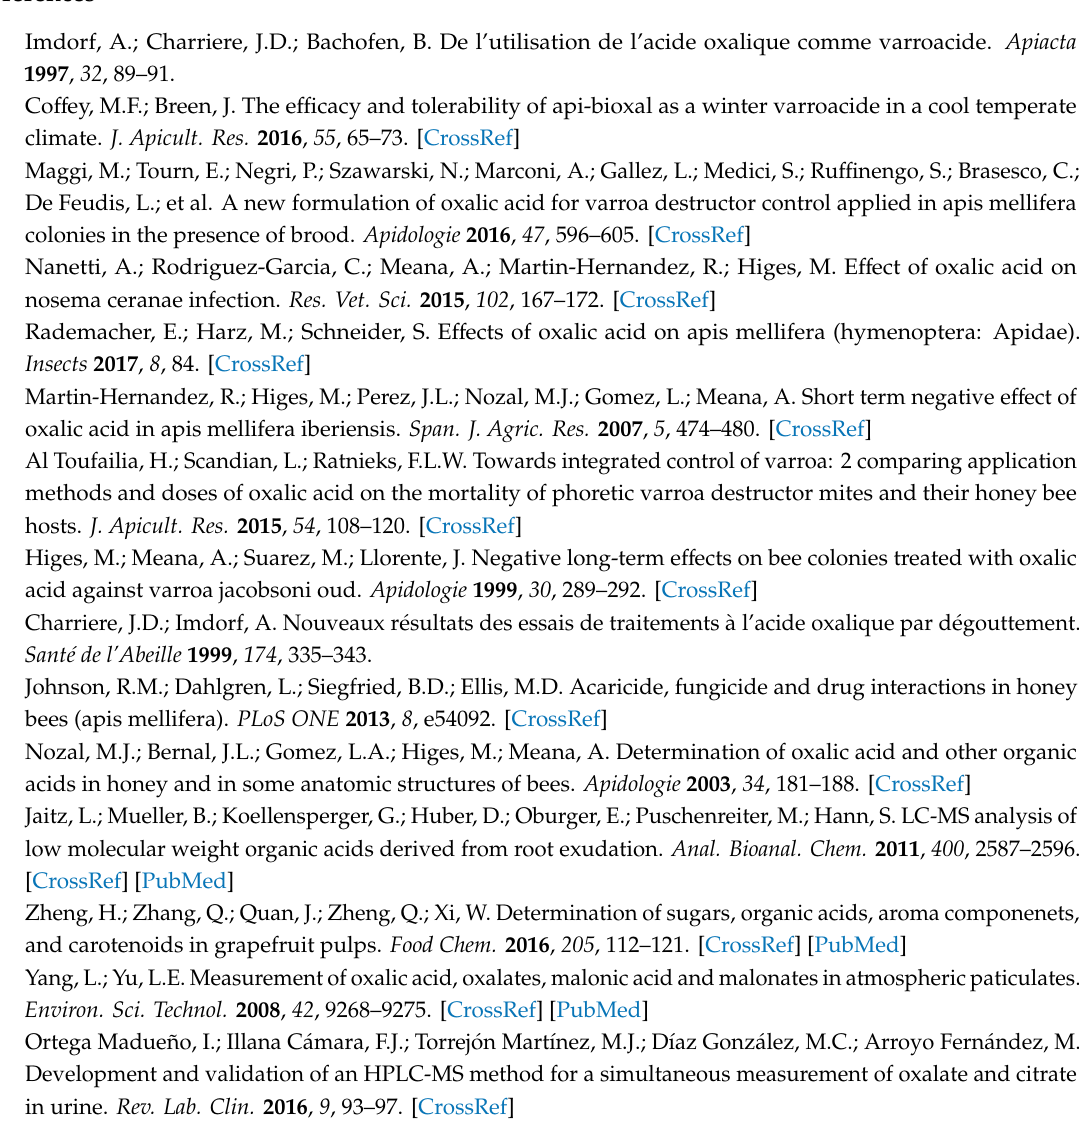
GC-MS system and operating conditions, Figure S1: HILIC-UV chromatogram of a blank honeybee sample extract, Figure S2: Magnified HILIC-UV chromatogram of a blank honeybee sample, Figure S3: HPLC-UV chromatogram of a standard solution of oxalic acid at 20 µ g / mL, Figure S4: Peak purity curve obtained for a positive bee sample in OA, Figure S5: TIC, MRM chromatograms of a OA positive bee sample, Figure S6: TIC, MRM chromatograms of a control bee sample, Figure S7: Full scan GC-MS total ion chromatogram of derivatized OA standard in ACN at 1 µ g / mL, Figure S8: HILIC-PDA chromatogram of a standard mixture of OA and LA at 10 µ g / mL (using phosphate bu ff er), Figure S9: HILIC-PDA chromatogram of LA and OA in standards solution mix (using ammonium acetate bu ff er), Figure S10: HILIC-ESI / MS SIM chromatogram of LA and OA in standards solution mix (using ammonium acetate bu ff